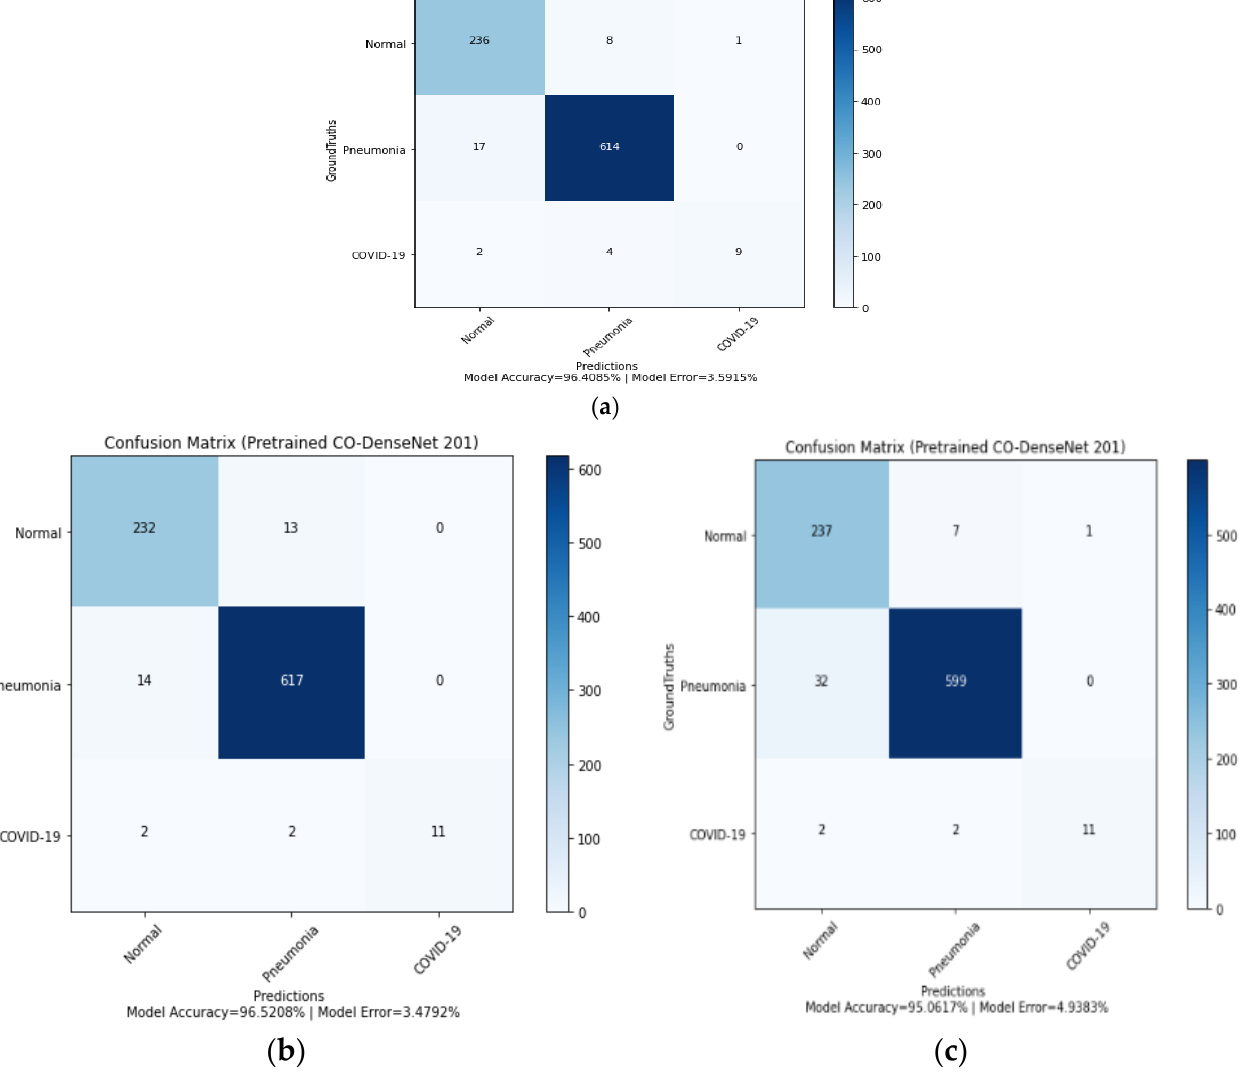
Figure 8. Confusion matrix for LDDNet: ( a ) Adam optimizer, ( b ) Nadam optimizer, and ( c ) SGD optimizer.